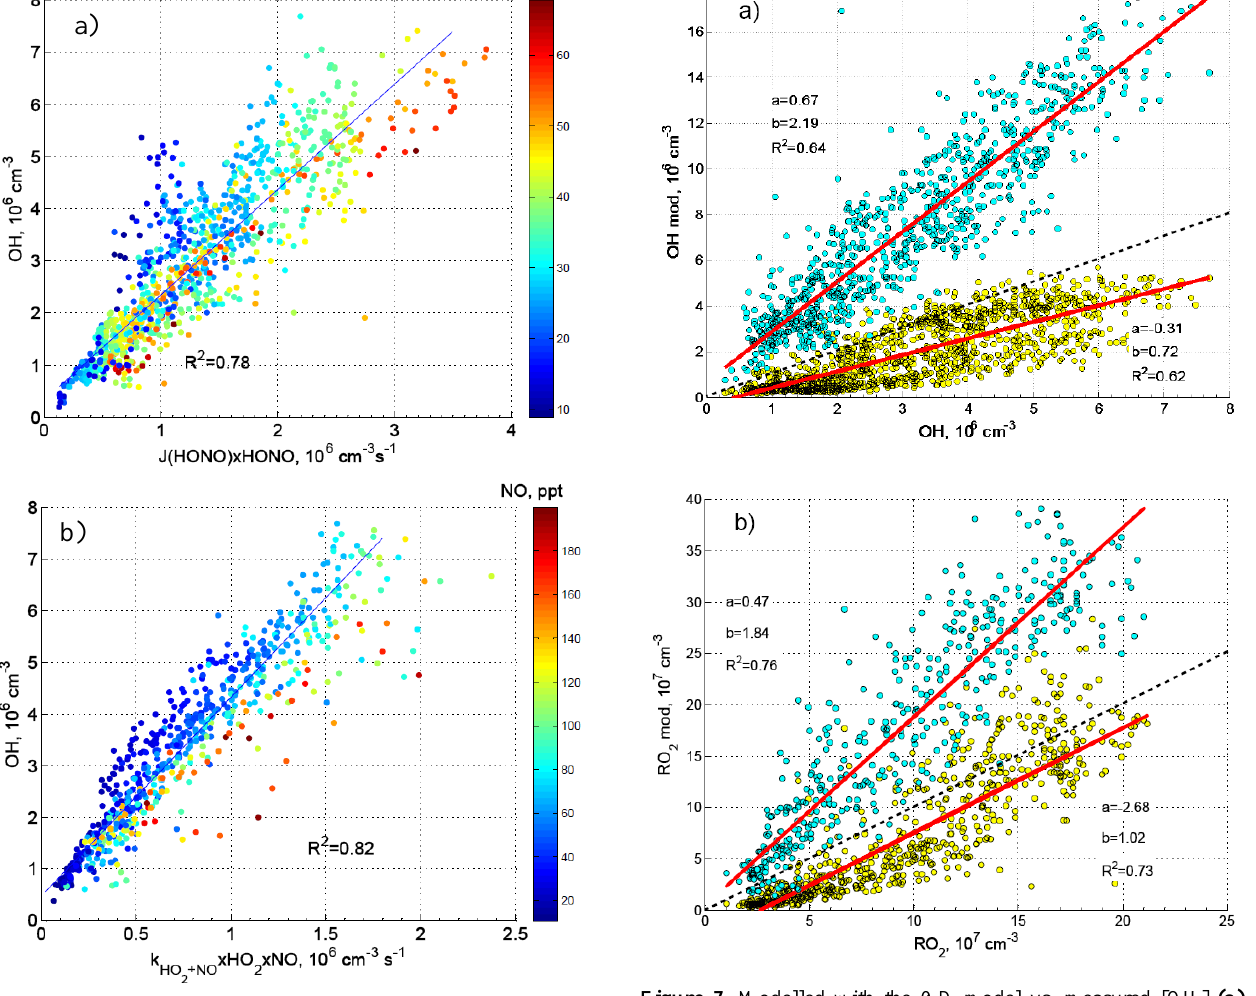
Figure 6. Correlation of measured [OH] with production rates of OH radical by photolysis of HONO, P HONO (a) , and via reaction HO 2 + NO, P HO (b) . 2 + NO